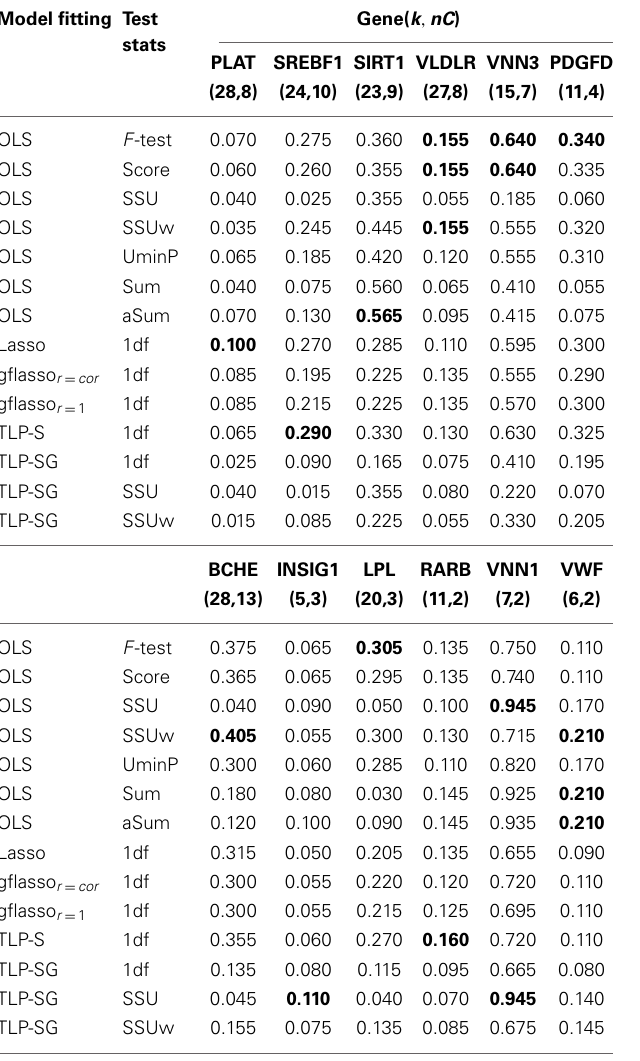
Table 7 | Empirical power based on the GAW17 data without CVs from 200 replicates of Q2, k , and nC denote the numbers of the total and causal RVs in a